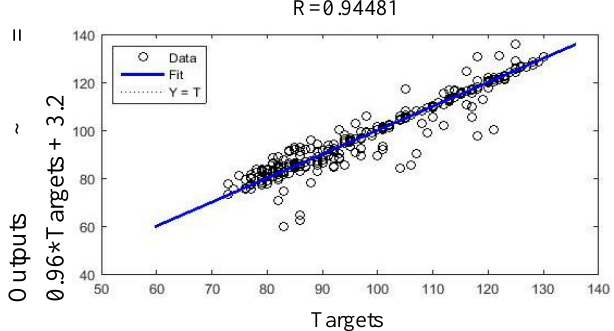
Fig. 8. Correlation between the targets and outputs for ANFIS